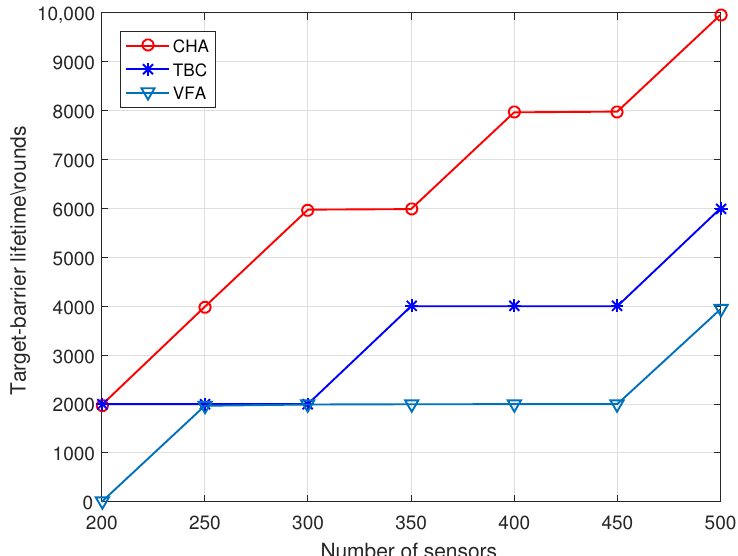
Figure 4. Target-barrier lifetime versus Number of sensors.